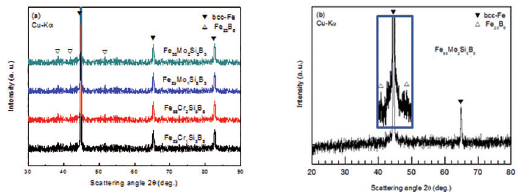
Si B M (M=Cr, Mo; 90-x 5 5 x